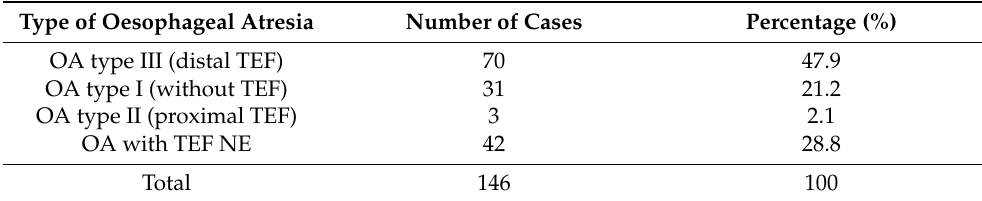
Table 3. Distribution of cases with oesophageal atresia according to Vogt’s classification or location of the fistula during the period 2007–2019 in the Valencian Region.